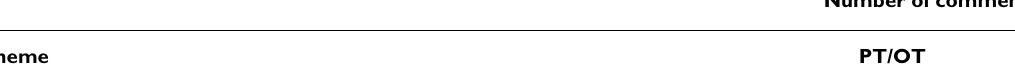
Table 5: Themes of written comment provided by respondents